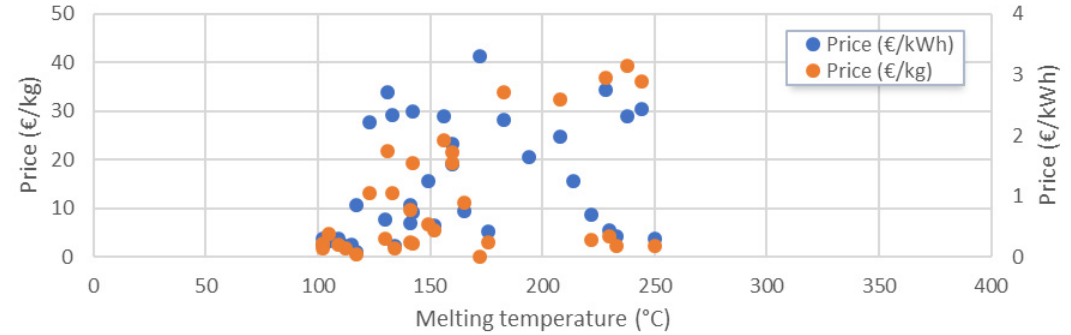
Figure 6. Price ranges for PCM in terms of €/kg and €/kWh (based on [25]).